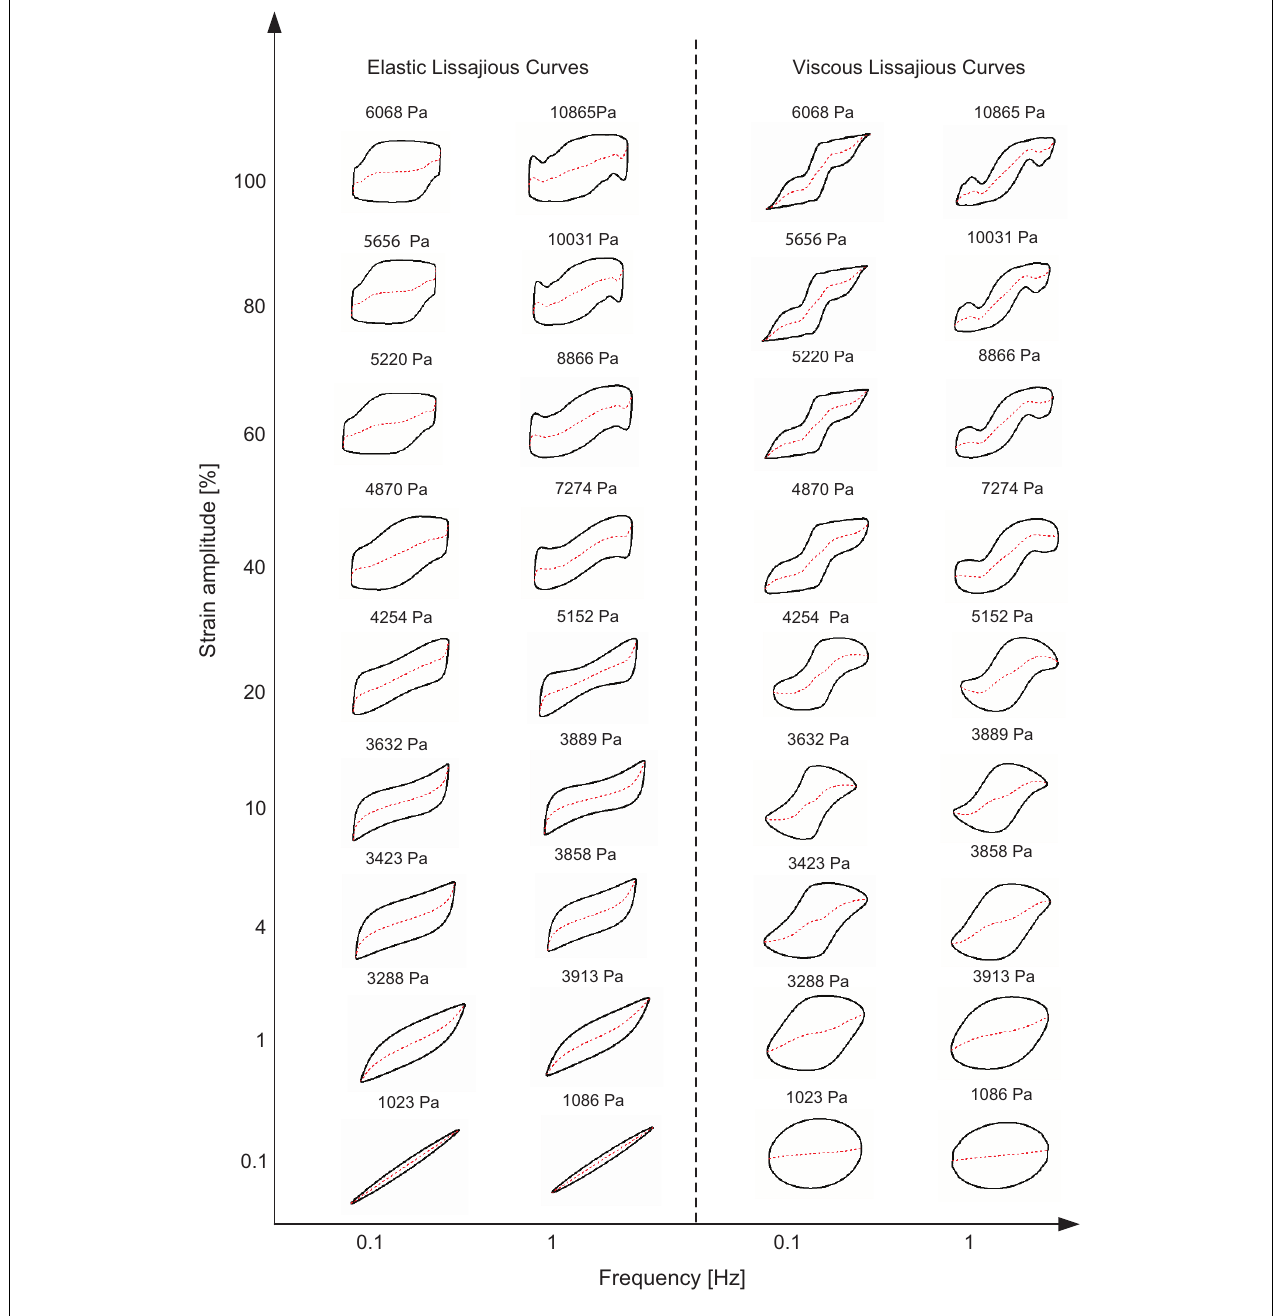
FIGURE 7 | Elastic and viscous Lissajous curves of MRG-70 generated from the strain-controlled oscillatory shear under the magnetic field of 194 kA/m. Each curve is positioned according to the imposed value of shear strain and frequency. The red dash line represents the corresponding decomposed elastic and viscous stress. The value above each curve is the maximum shear stress τ max